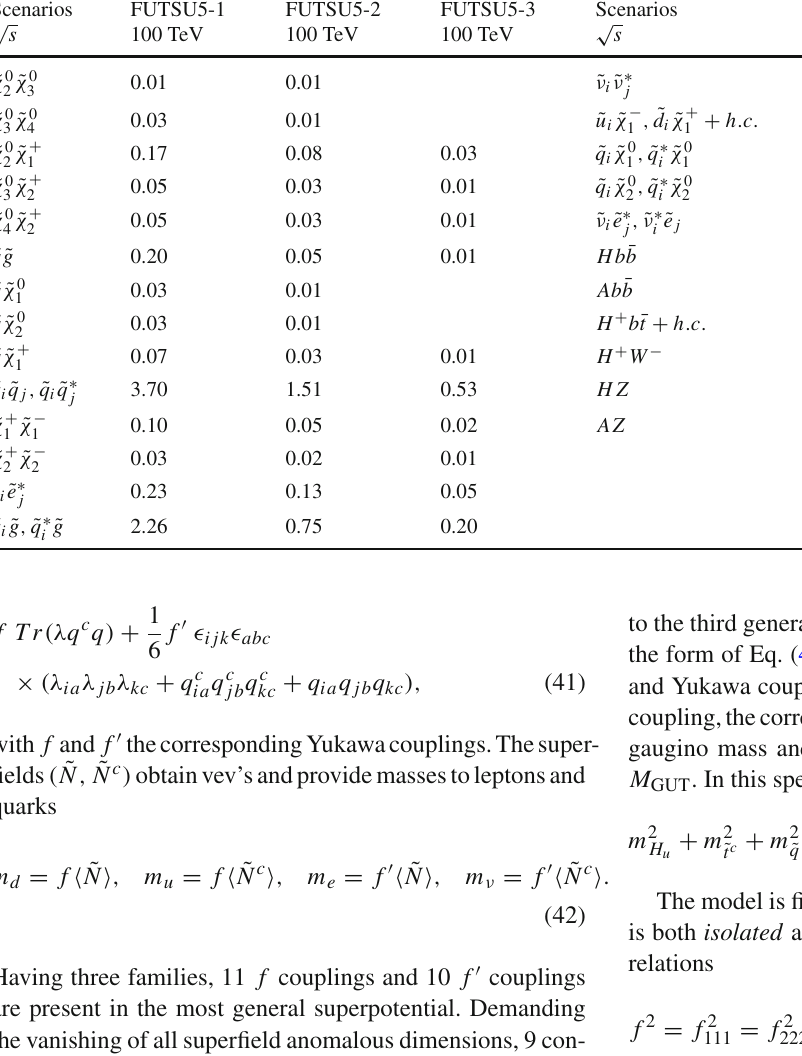
Table 6 Expected production cross sections (in fb) for SUSY particles in the FUTSU5 scenarios Scenarios √